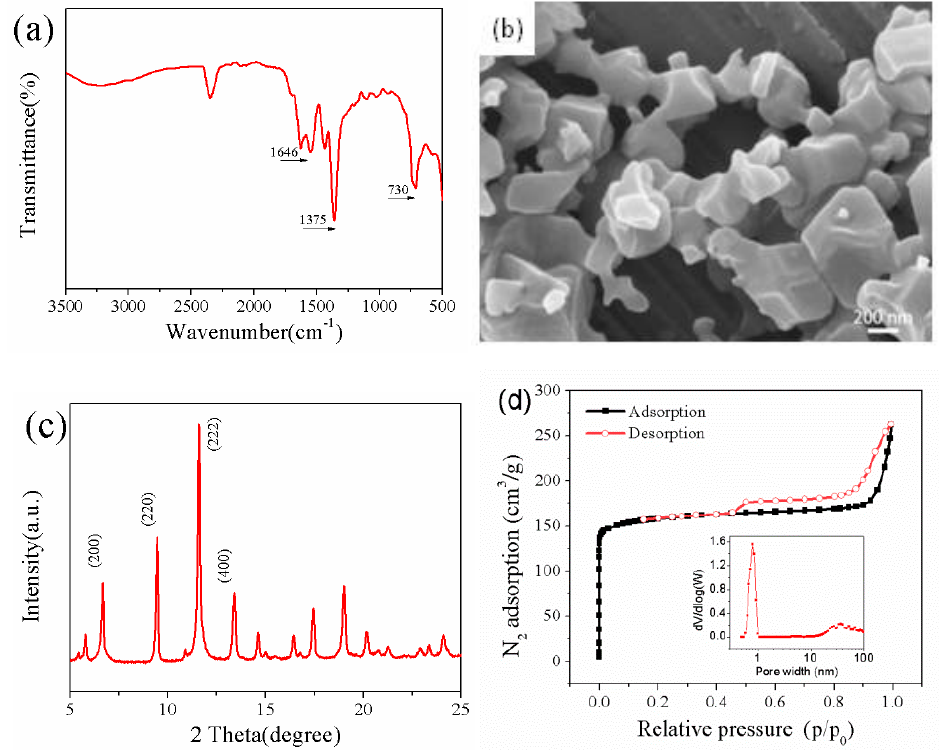
Figure 3. The FTIR ( a ), SEM ( b) , XRD ( c ), and N 2 sorption isotherms and pore size distribution ( d ) analyses of the CuBTC particles.